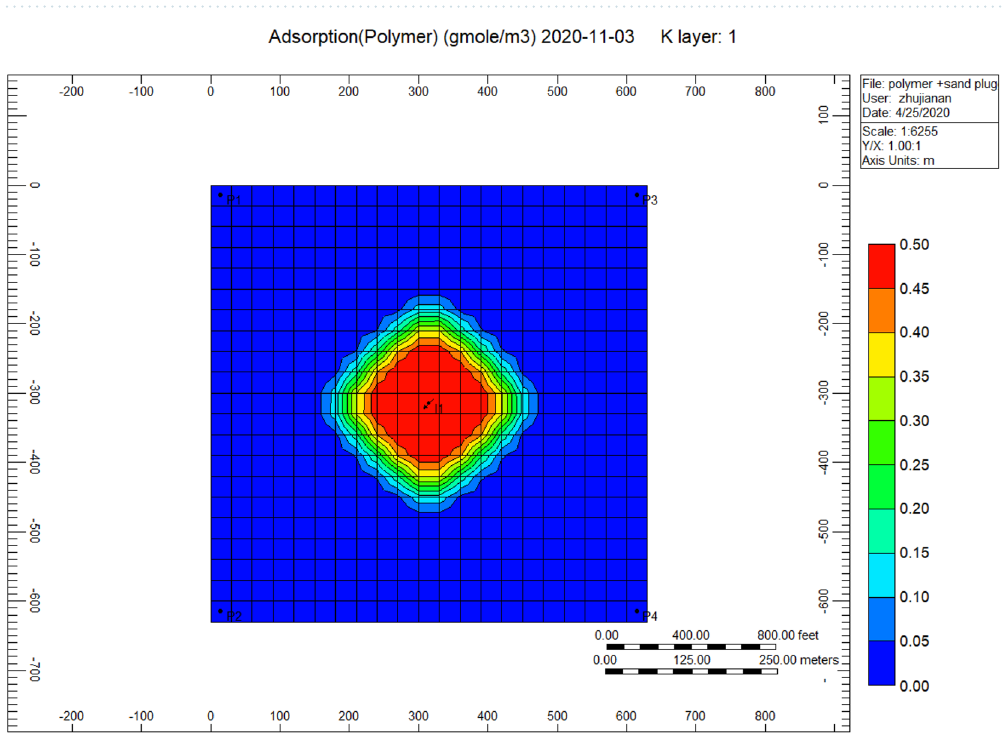
Figure 7. Shows the polymer adsorption throughout the polymer sand plug model CMG STARS 2017.10 URL: https:// www. cmgl.